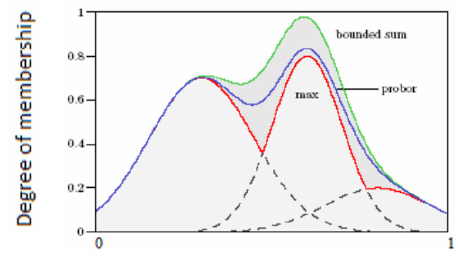
Figure 10. Three methods of fuzzy set aggregation.